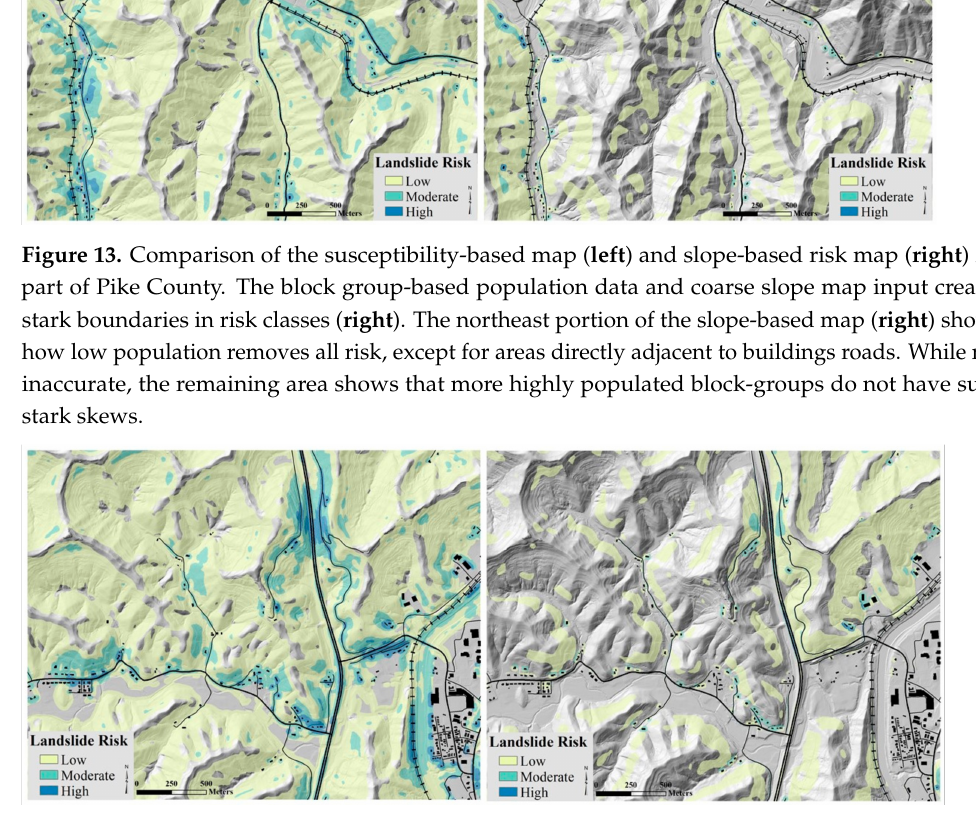
Figure 14. Comparison of the susceptibility-based map ( left ) and slope-based map ( right ) in part of Floyd County. The block group-based population data and coarse slope map input creates stark boundaries in risk classes ( right ). Compared to the map on the left, under prediction is apparent in the slope-based map ( right ), and population block-group data skews the model results between boundaries.